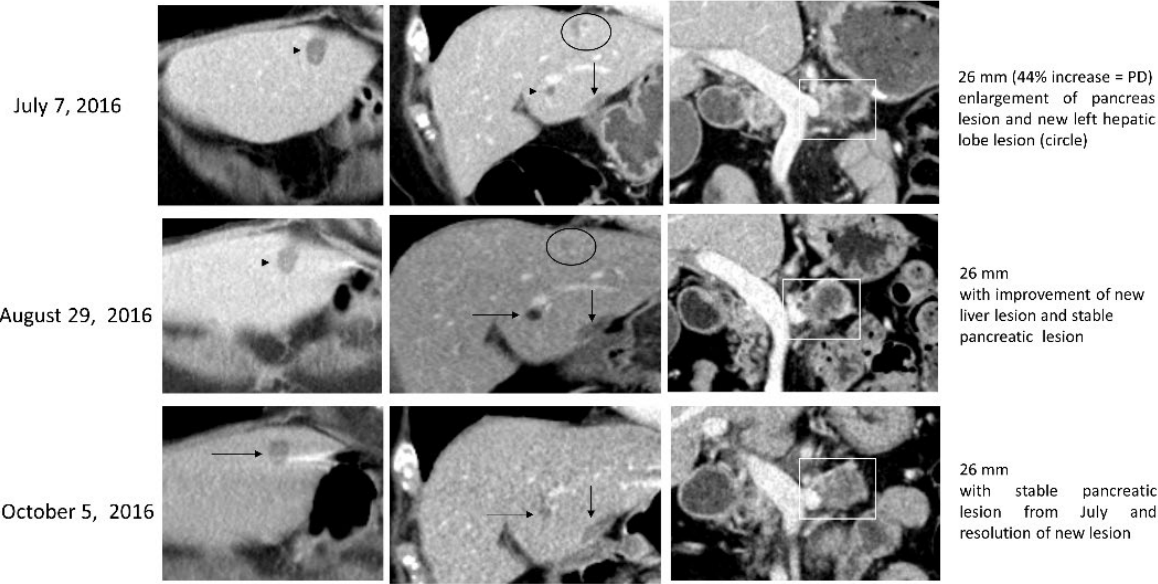
Figure 2. Case 1 treatment responses. Legend: On August 2016, during MMC treatment, we can